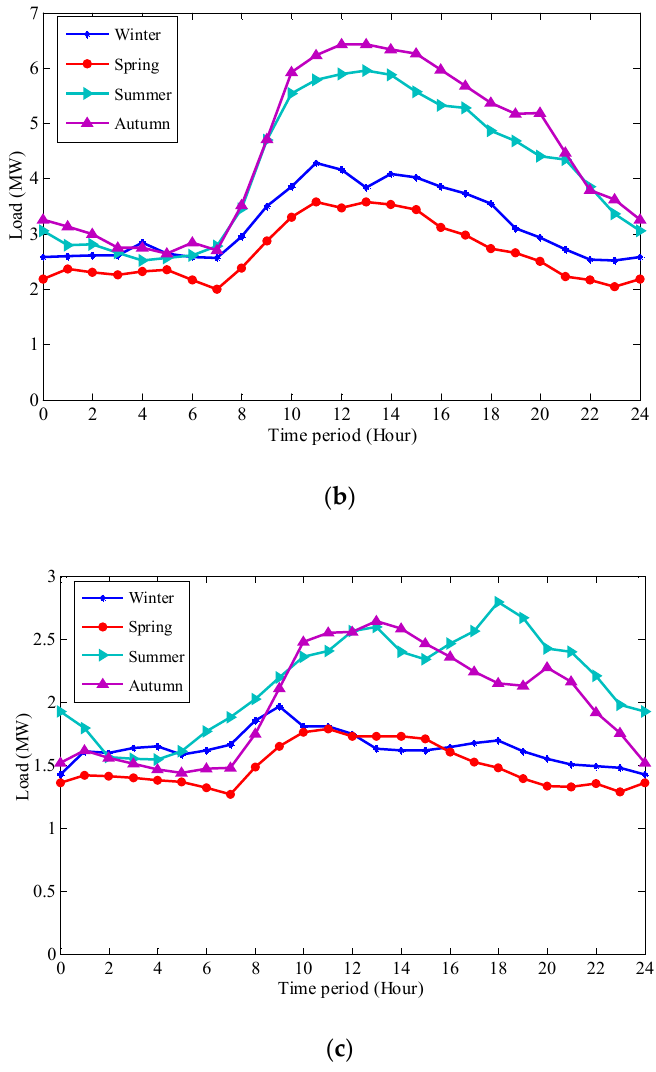
Figure 1. Three types of typical daily load curves in different seasons: ( a ) residential load; ( b ) commercial load; and ( c ) industrial load .